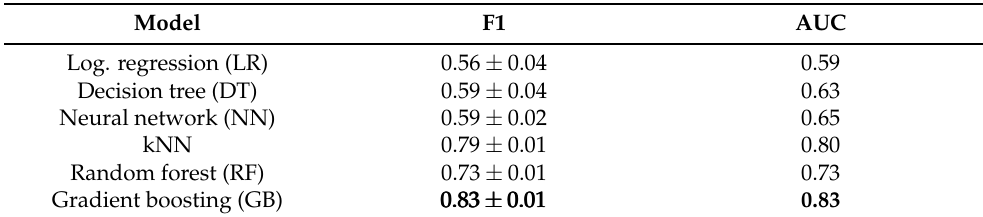
Table 1. Baseline classification models and their performance. The metrics are F1-measure and AUC.